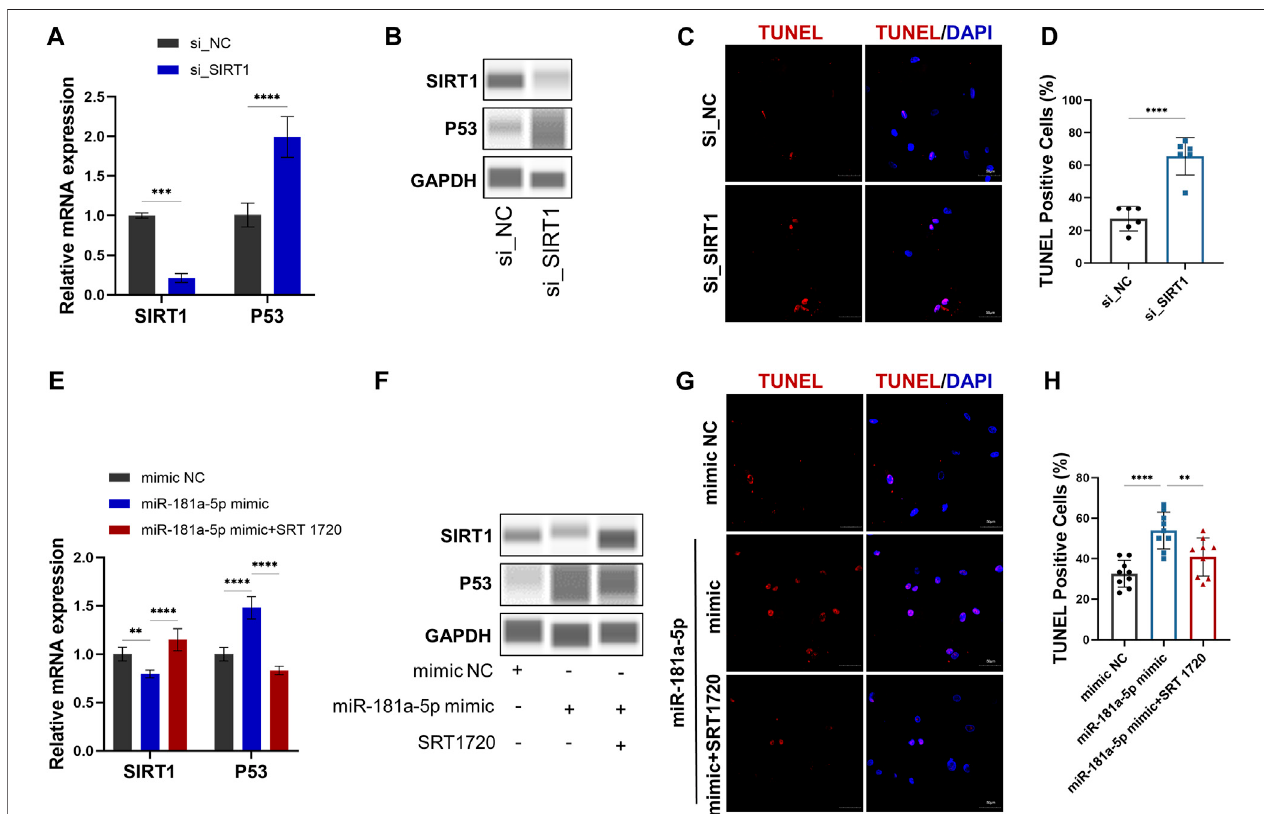
FIGURE4| MiR-181a-5p stimulatesapoptosisofchondrocytesbytargetingtheSIRT1/P53pathway invitro . (A,E) RelativemRNAexpressionofSIRT1andP53in chondrocytes. (B, F) Protein expression results of Wes Simple Western System using the “ Lane ” function of the Compass software. (C,G) Representative images of TUNELstaininginchondrocytes.(red,TUNEL-positivestaining;blue,DAPI).Scalebar=50 μ m. (D,H) TUNEL-positivecellcounts(%). (D) n =6/group. (H) n =9/group. Data presented as Scatter dot plot with bar (mean ± SD). T-test was employed for comparisons between two groups, one-way analysis of variance with Tukeys post test for multiple comparisons was used for groups of three. ** p < 0.01; *** p < 0.001; **** p <